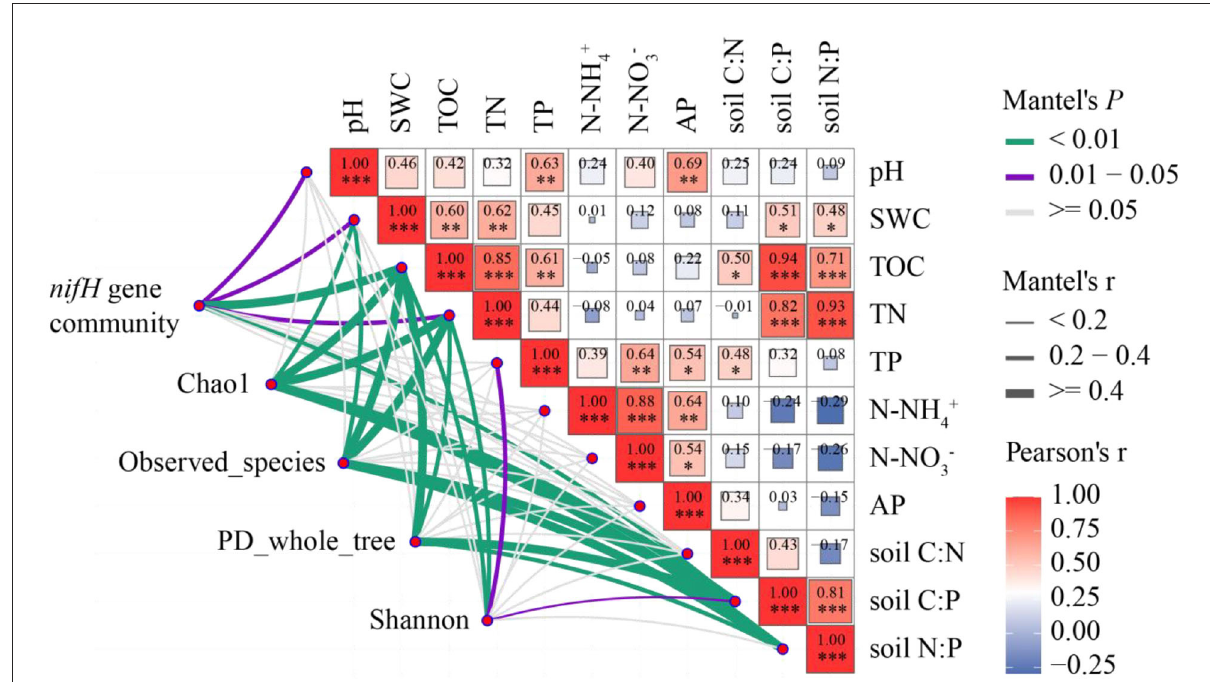
FIGURE6 Correlations among nitrogen-fixing microbial community and diversity and soil physicochemical properties. Mantel edge width corresponds to Mantel r -value, and edge color indicates statistical significance. The color gradient of Pearson correlation coefficient r indicates the pairwise correlation of variables. The nitrogen-fixing gene community includes all nitrogen-fixing bacteria phylum. * 0.01 < P < 0.05, ** P < 0.01, *** P <